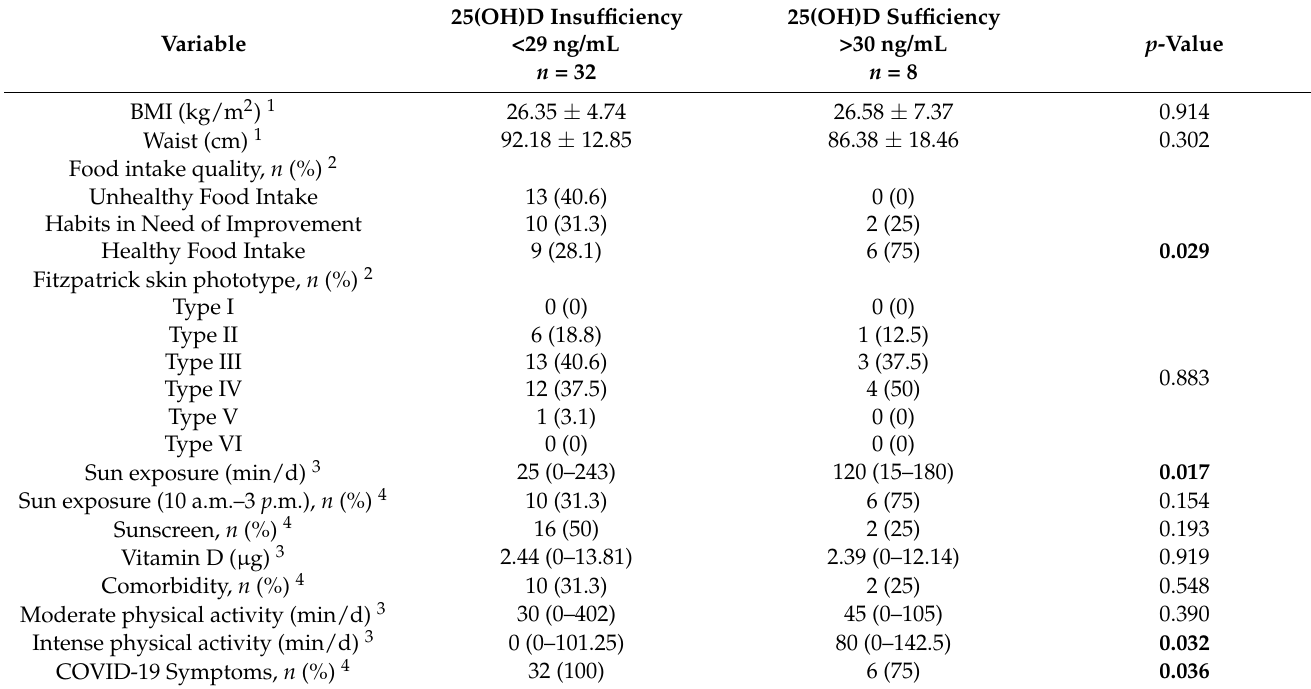
Table 3. Comparison between patients with 25(OH)D insufficiency and